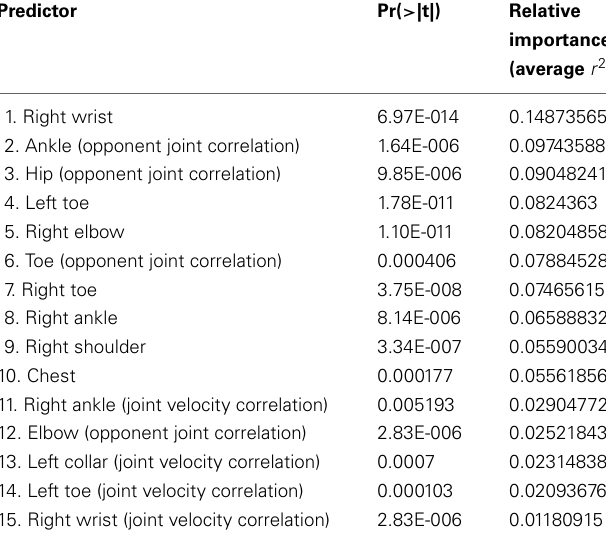
FIGURE 7 | The joints whose velocity profile was most predictive for the recognition performance as observed in the